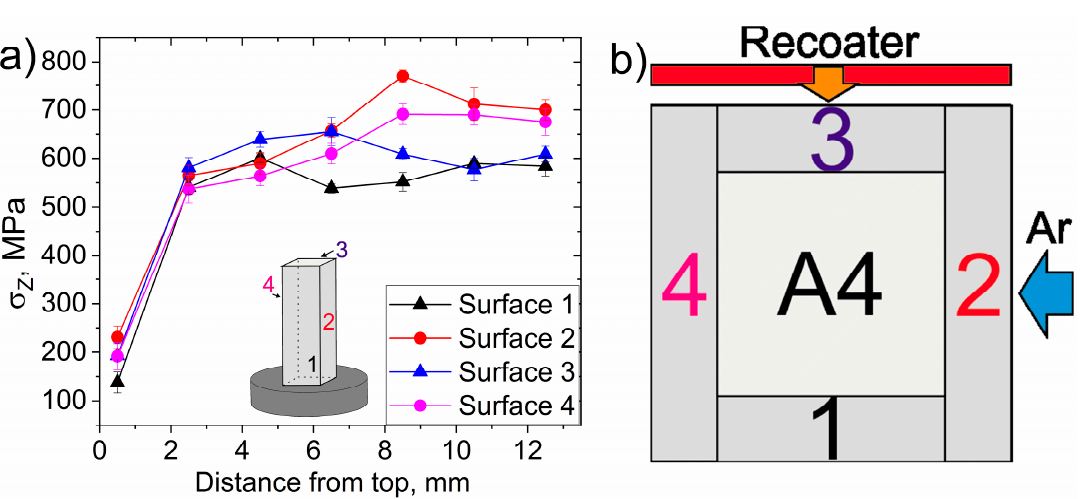
Figure 6. ( a ) RS along the building direction on different faces for A4 cuboid, ( b ) schematic top view on the sample in build chamber. Table 2. Roughness at different faces of cuboid A4.